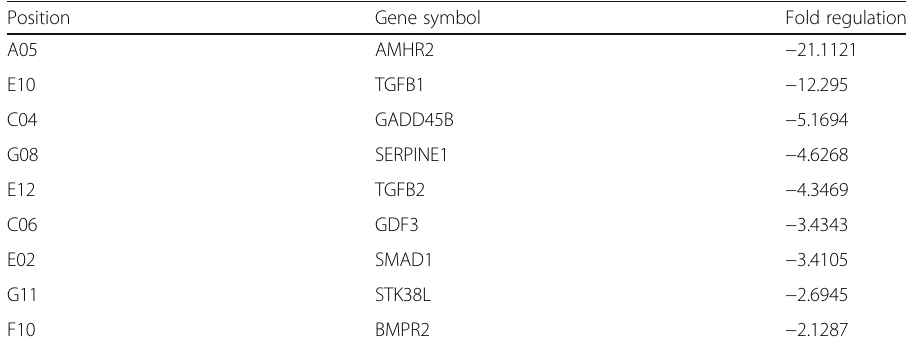
Table 4 Downregulated genes in TGF- β 1 knockout cell lines Position Gene symbol Fold regulation A05 AMHR2 − 21.1121 E10 TGFB1 − 12.295 C04 GADD45B − 5.1694